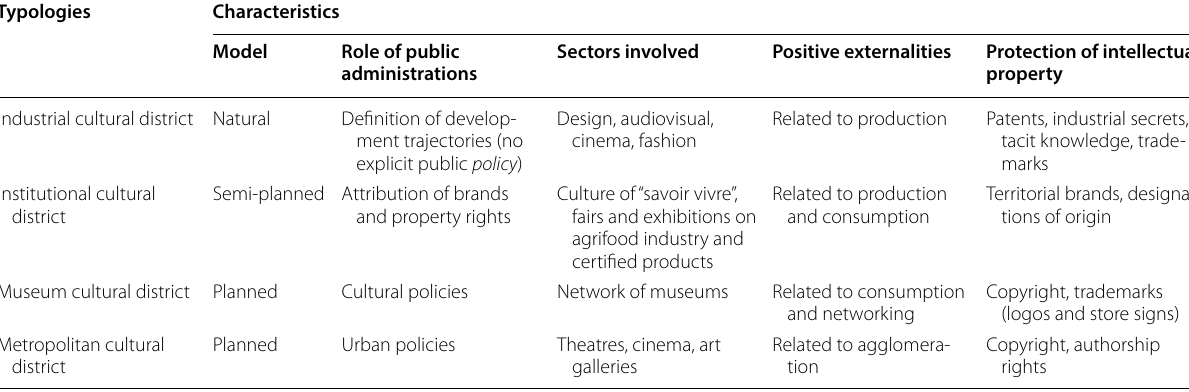
Table 1 Classification of cultural districts according to the economic-institutional features. Source: elaboration of the authors on Santagata (2002) and Hinna and Seddio